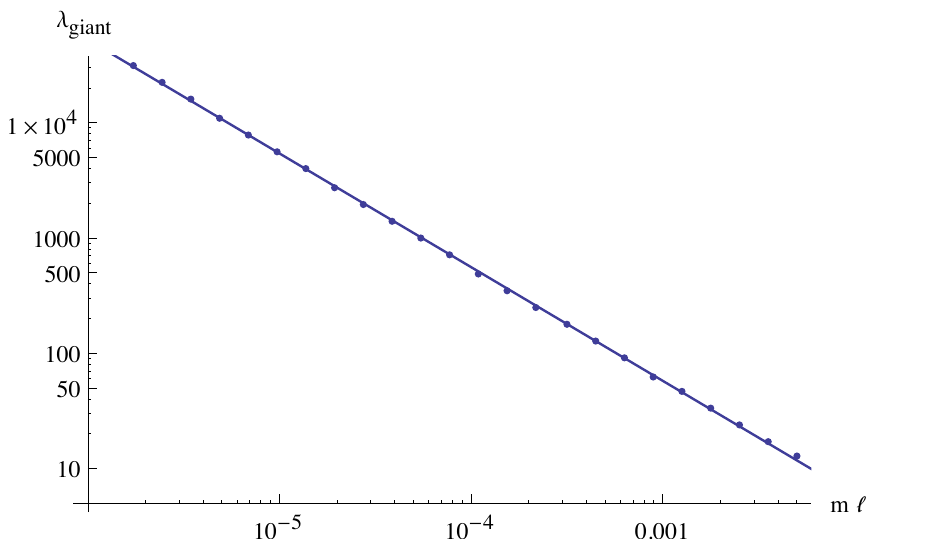
Figure 2 . (cid:21) giant vs. m‘ on a log-log scale for a subchain of 10 harmonic oscillators within a longer chain of 500 oscillators with periodic boundary conditions.